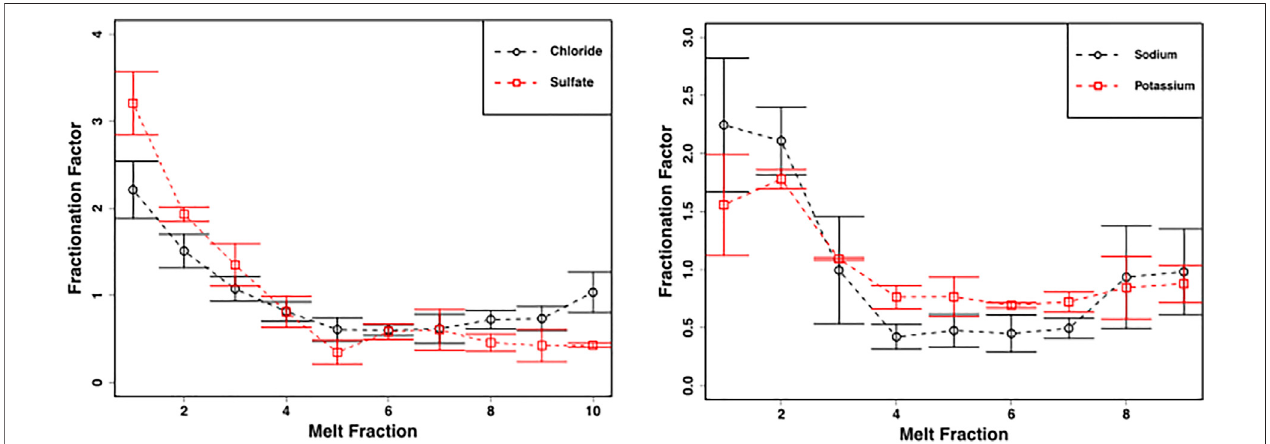
FIGURE 4 | Mean ± SE chloride and sulphate concentrations (left panel) and sodium and potassium concentrations (right panel) from homogenized snow pack sections in crude laboratory melt experiment ( Figure 2C ) ( n = 3) demonstrate fractionation of solute into the fi rst meltwater fractions.